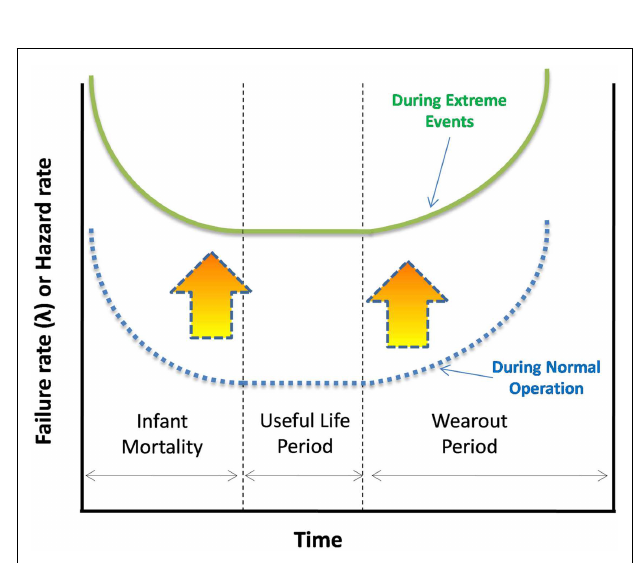
FIGURE 6 | Bath-tube curve during severe accidental conditions